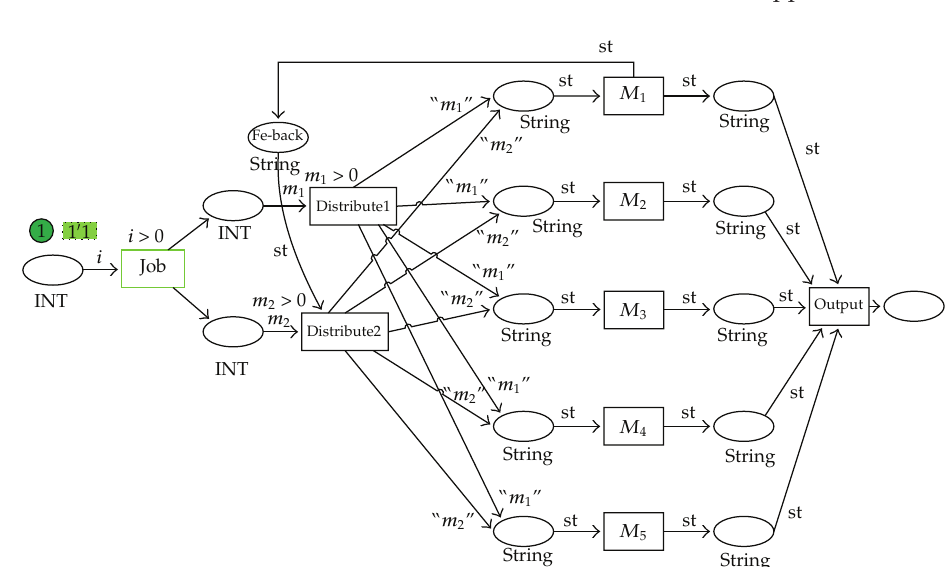
Figure 4: Example model for two jobs with one operation on five